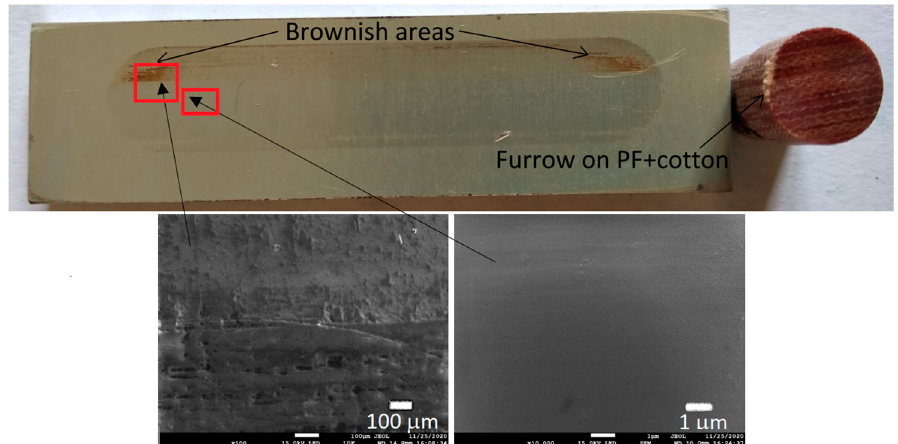
Figure 6. Photographs and SEM micrographs of Al 2 O 3 tribological pairs after a tribological test with PF + cotton.